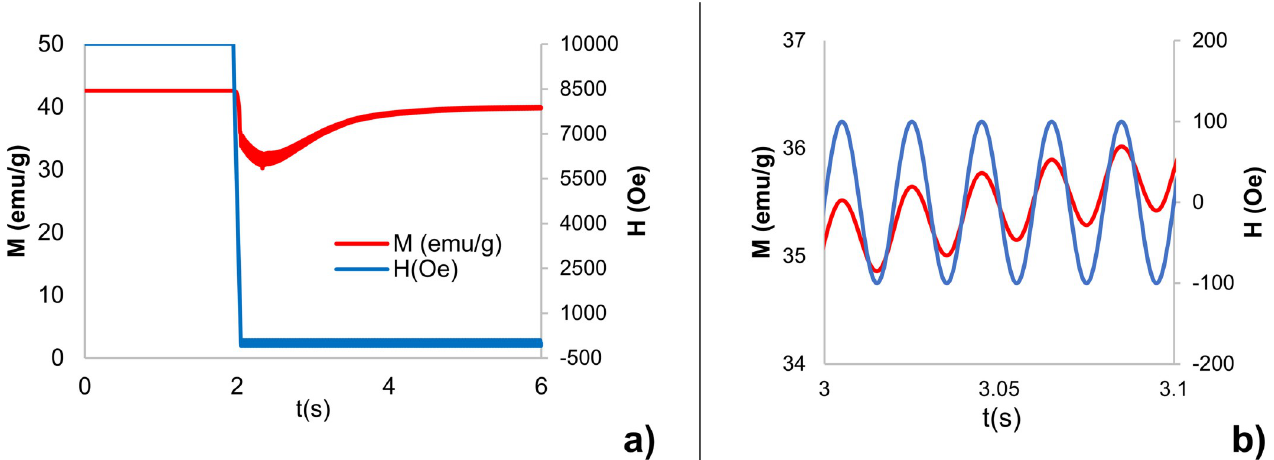
Fig 2. MENPs cores magnetization behavior. DC magnetization loops of a) CFO and b) FO core 50 nm nanoparticles.